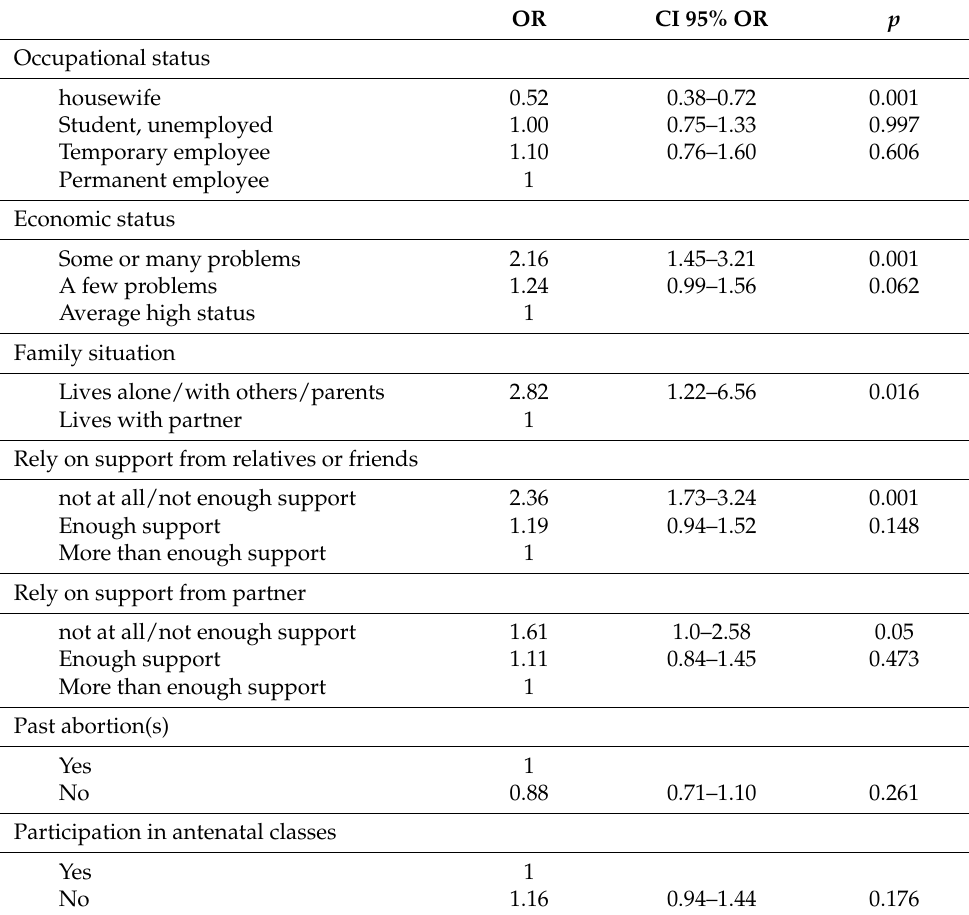
Table 4. Association of sociodemographic and socioeconomic characteristics and risk of depression (EPDS score ≥ 9): results of multiple logistic regression model. OR CI 95% OR